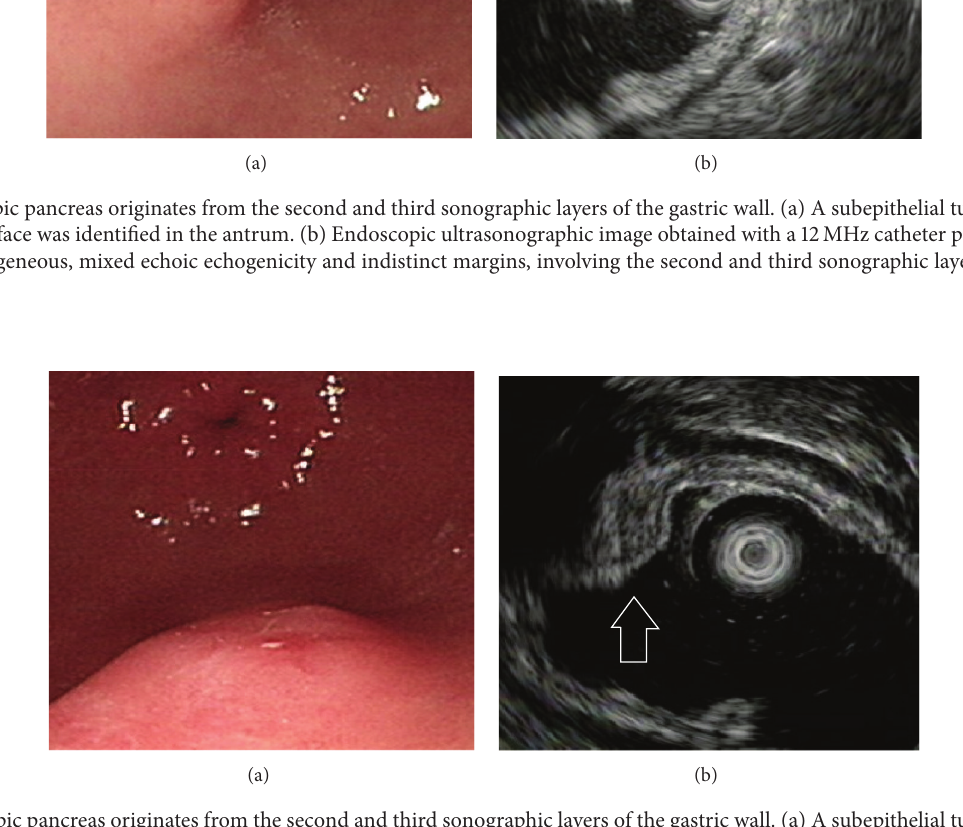
Figure 2: Ectopic pancreas originates from the second and third sonographic layers of the gastric wall. (a) A subepithelial tumor with intact but uneven surface was identified in the antrum. (b) Endoscopic ultrasonographic image obtained with a 12MHz catheter probe. The tumor exhibits heterogeneous, mixed echoic echogenicity and indistinct margins, involving the second and third sonographic layers of the gastric wall